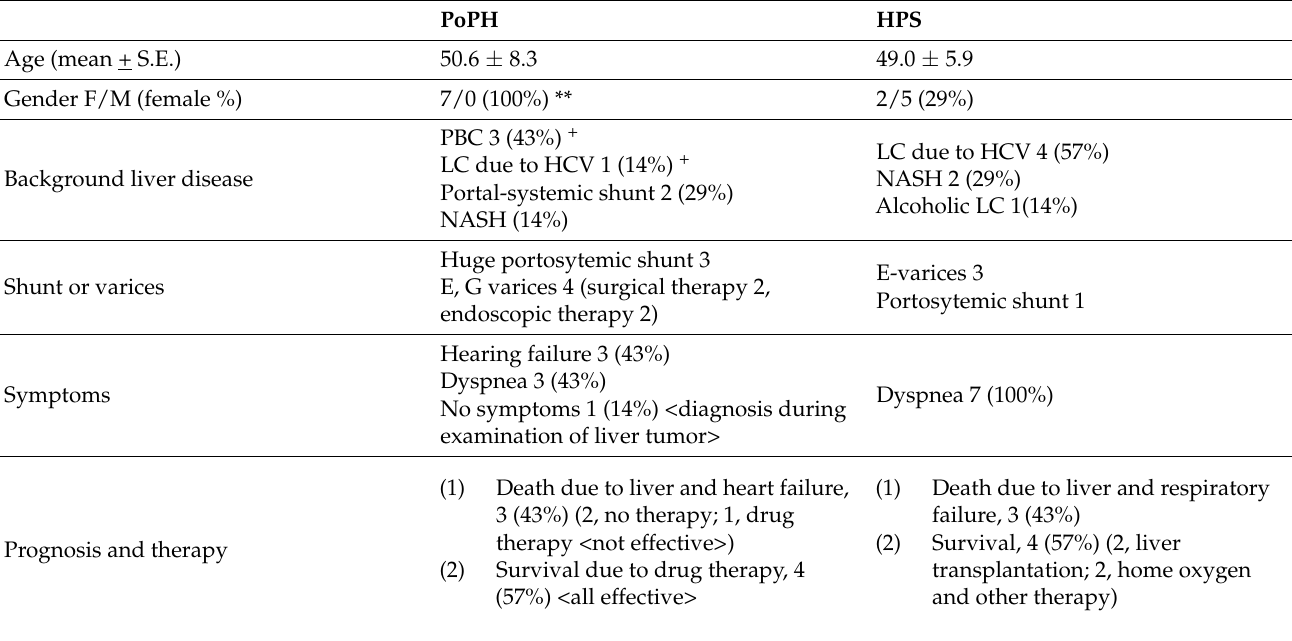
Table 2. PoPH and HPS cases in our department